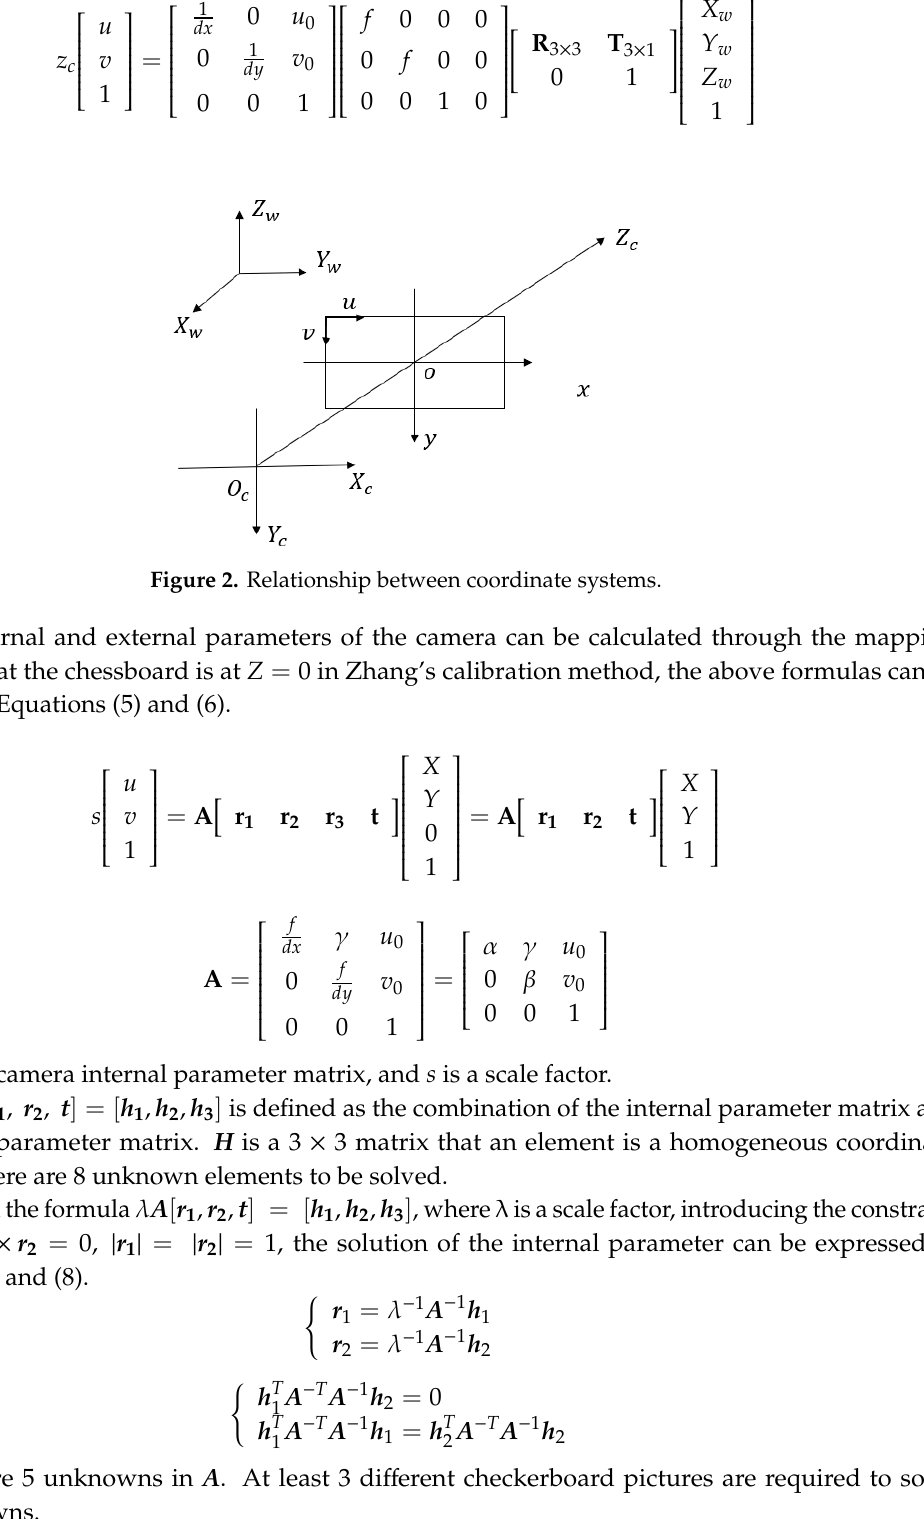
3 of 18 Figure 1. Flowchart of object body length analysis.